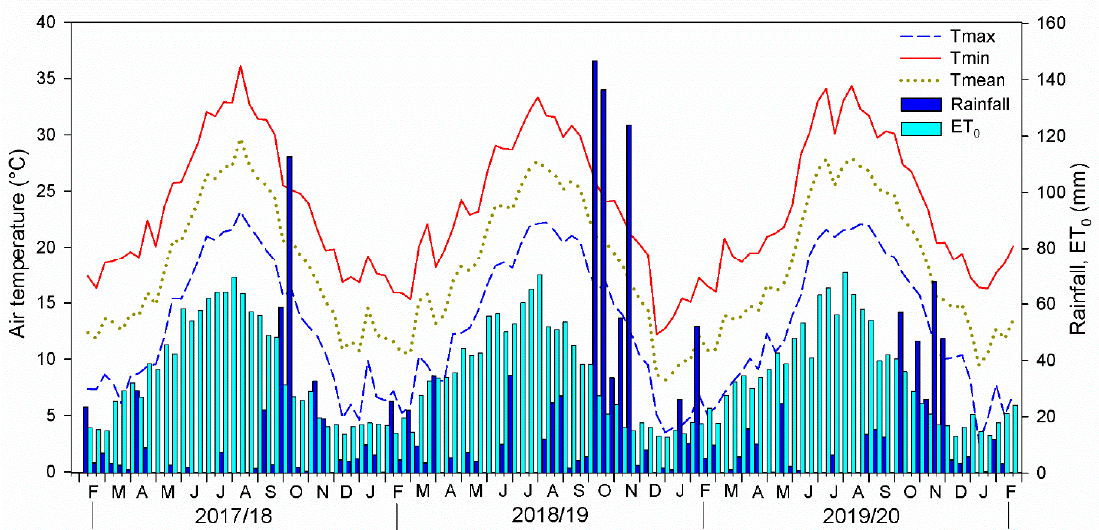
Figure 2. Meteorological trend, maximum (T max ), mean (T mean ) and minimum (T min ) air temperatures (°C), rainfall, and reference evapotranspiration (ET 0 ) (mm), at the Experimental Farm of the